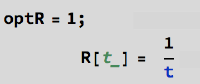
Figure 18. Part of the structure of the [SInt] algorithm corresponding to Option 1 to input r